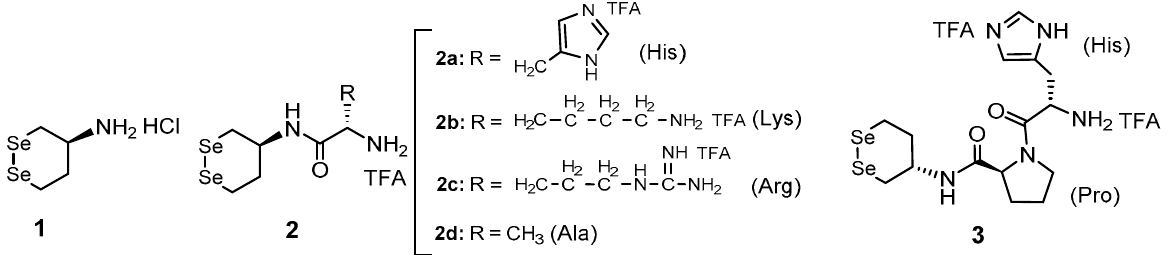
Figure 3. Diselenide compounds reported previously.